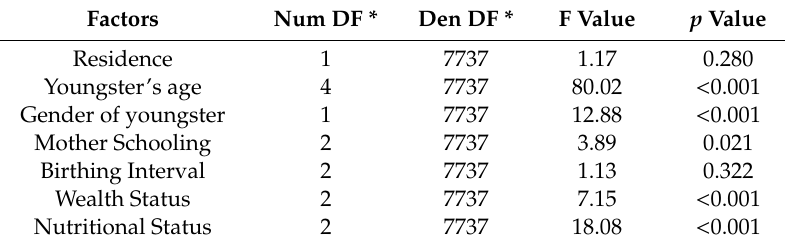
Table 5. Type 3 Test of fixed e ff